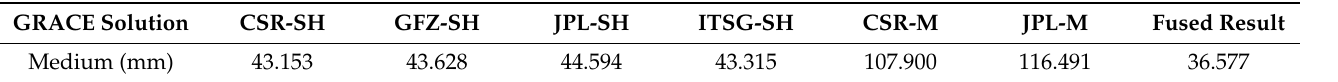
Table 3. Uncertainties of TWSC results from the six GRACE solutions and fused results estimated by the GTCH method.